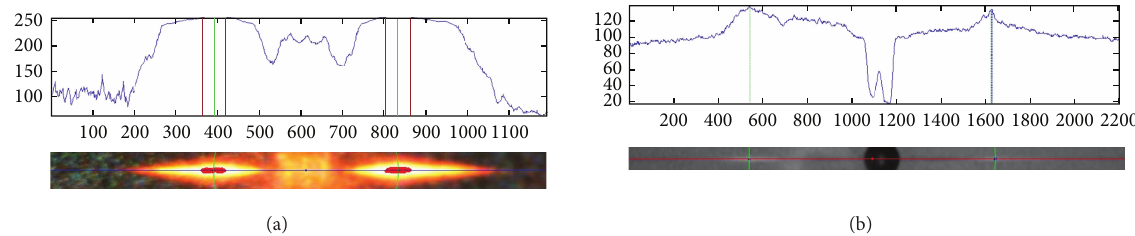
Figure 4: Plots of the brightest pixel with the corresponding region of interest for (a) the flame view camera and (b) the droplet view